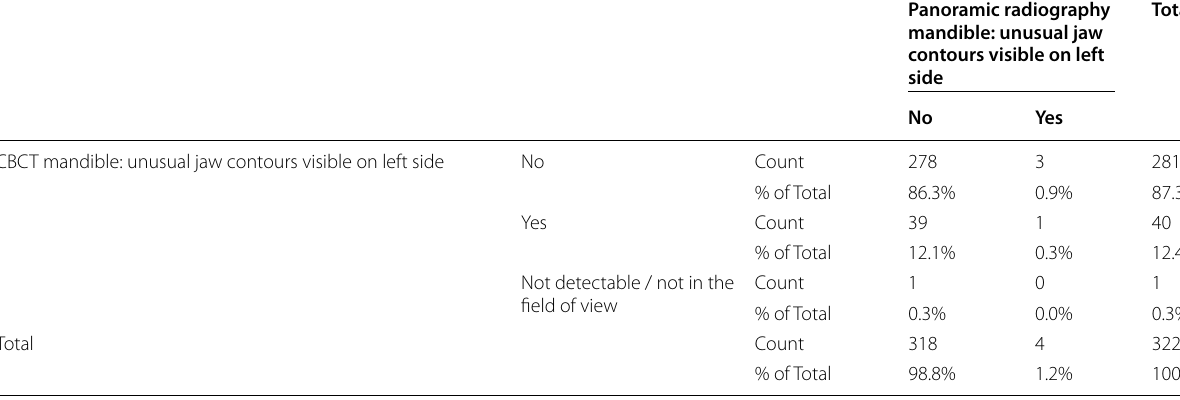
Panoramic radiography mandible: unusual jaw